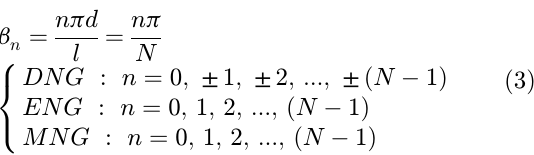
DNG transmission line are negative, zero, and positive values, while the ENG and MNG transmission lines support zero and positive propagation constants.